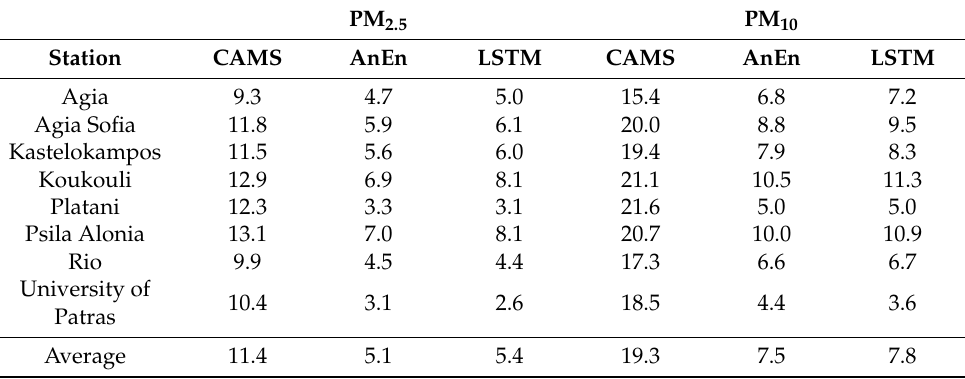
Table 4. RMSE of PM 2.5 and PM 10 for forecasts of CAMS, AnEn and LSTM at each station. PM